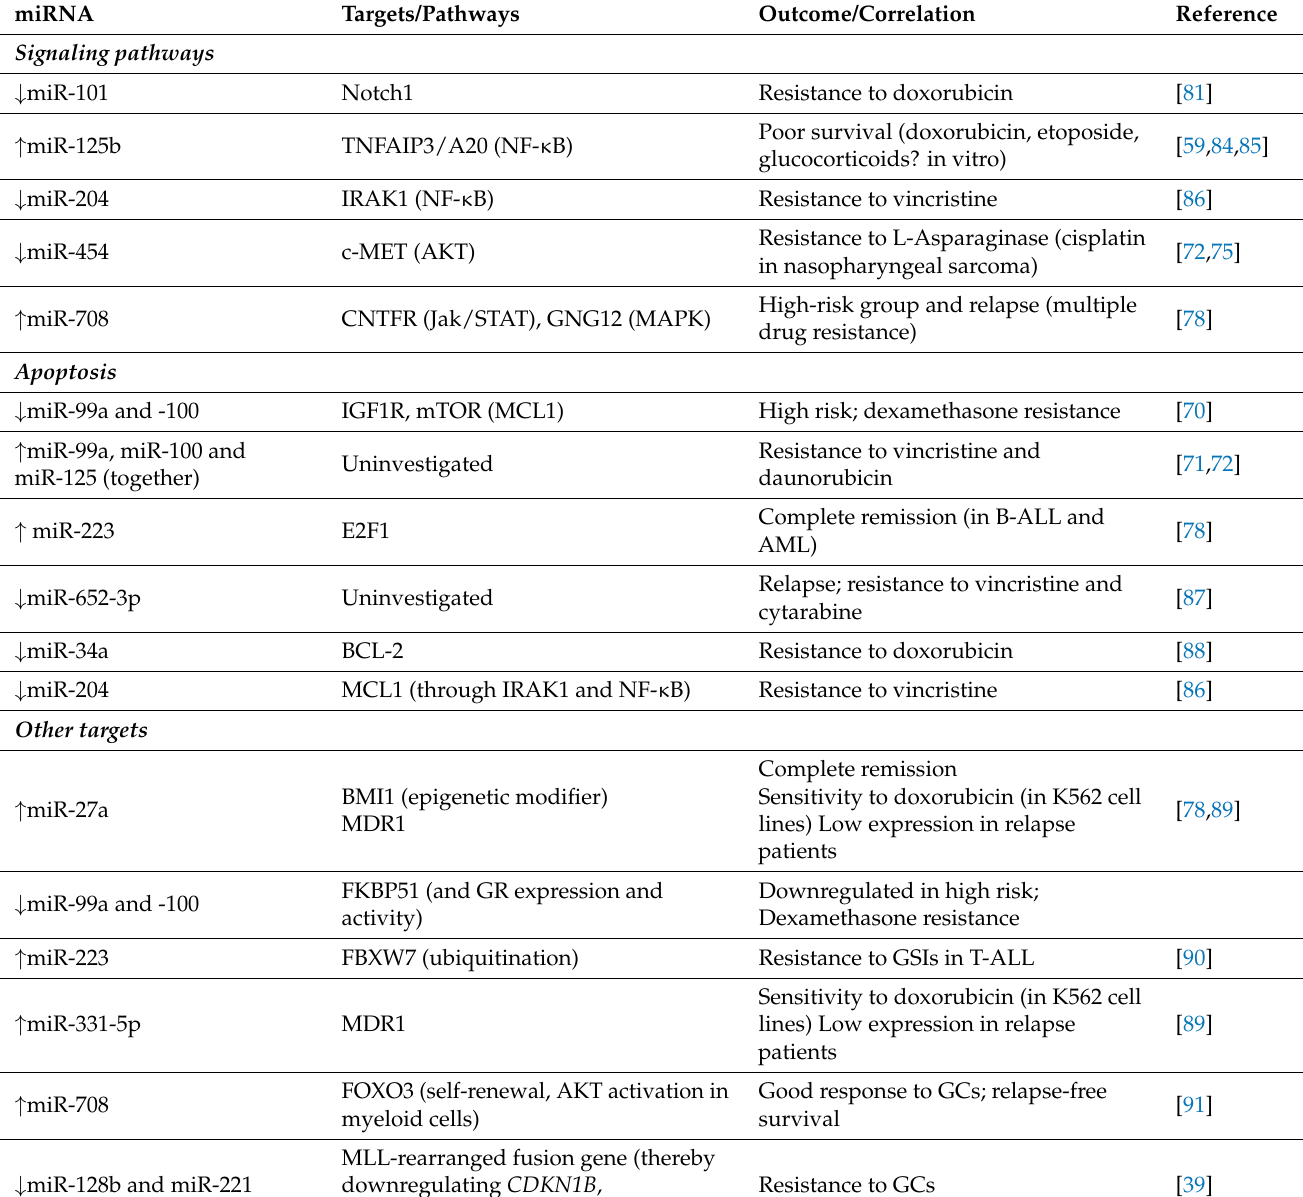
Table 2. miRNA, their targets and their effects in childhood